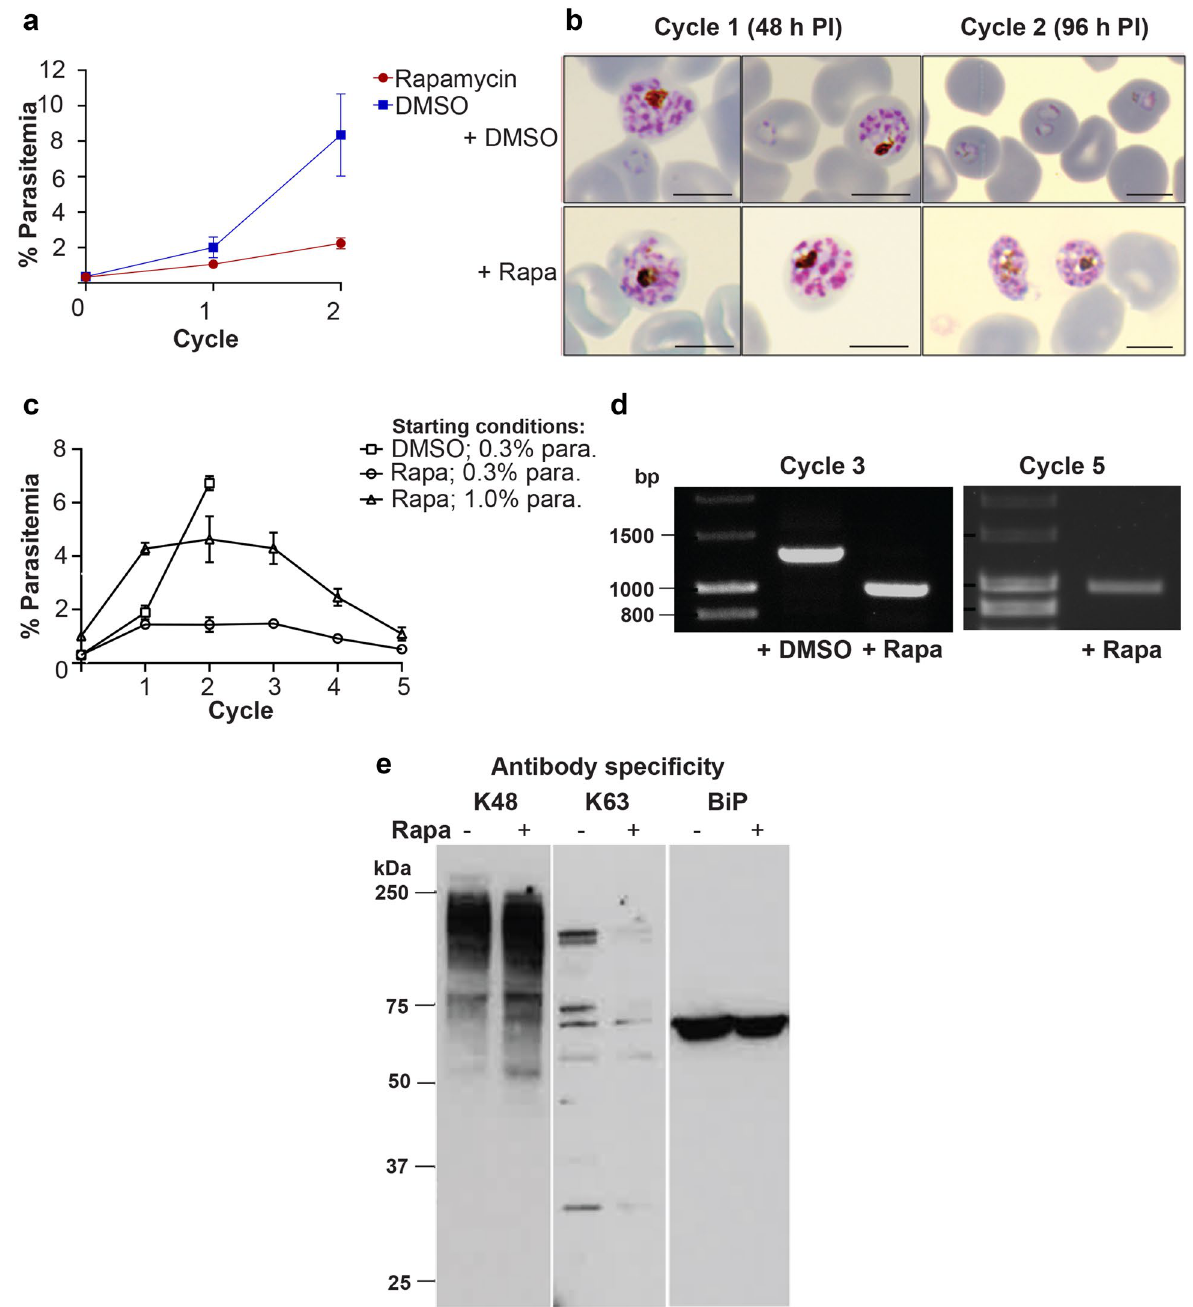
Figure 2. Effect of an inducible Pfubc13 knockout in P. falciparum on parasite growth and ubiquitin ubiquitylation ( a ) Growth over two cycles of intraerythrocytic development for parasites treated with either DMSO (control) or rapamycin to induce Di-Cre mediated excision within ubc13 . A synchronised parasite population (0.2% parasitemia) was treated with either DMSO or rapamycin for 24 h; parasitemia was measured by FACS analysis. Data are shown as mean ± standard error of the mean (SEM) from triplicate experiments performed in duplicate. ( b ) Analysis of parasites by light microscopy of Giemsa-stained thin smears, from parasites treated with either DMSO or rapamycin. At 48 h post invasion (PI), schizonts and ring stages were visible in DMSO treated cultures and there were fewer ring stages in the rapamycin treated cultures. By 96 h PI, second cycle ring stages were visible in DMSO-treated cultures and morphologically abnormal late stage parasites were predominant in rapamycin-treated cultures. Scale bar is 5 µm. ( c ) Parasitemia over up to 5 cycles of intraerythrocytic growth. The control (DMSO-treated) parasites were monitored for only two cycles; starting parasitemia, 0.3%. The rapamycin-treated parasites were monitored over five cycles; starting parasitema, 0.3 and 1%. The data shown are mean ± SEM from duplicate experiments. ( d ) The parasite populations were monitored by PCR amplification with primers P1/ P4 (see Supplementary Fig. 1) at cycle 3 and cycle 5; no parasites without excision were detected in the rapamycin treated sample . ( e ) Analysis of schizont lysates by immunoblotting with antibodies specific for either Lys48 or Lys63 ubiquitylation of ubiquitin. Equal amounts of protein from rapamycin-treated or –untreated parasites at 44 h PI were resolved by SDS-PAGE, transferred to nitrocellulose and then probed with antibodies specific for either K48 or K63 ubiquitin linkages, or antibodies specific for BiP as a loading control. Full length gels and immunoblots are presented in Supplementary Figs. 3 and